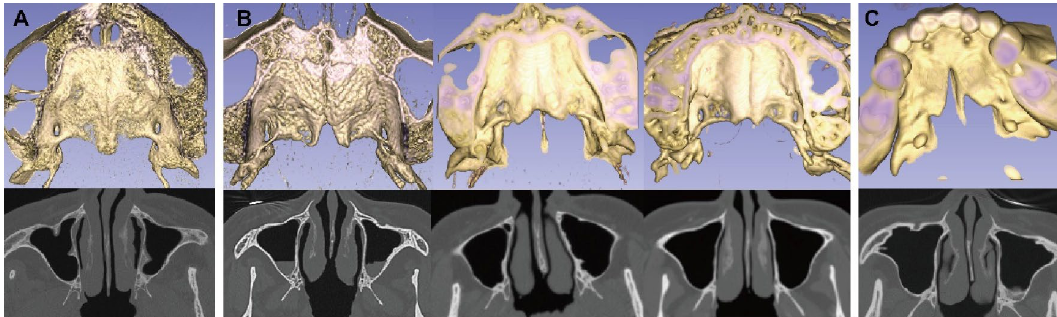
Figure 2. Images of the hard palate bony notch (top) and vomer deformity (bottom). ( A ) Normal hard palate and vomer in patients in the control group. ( B ) Three patients with occult submucosal cleft palate. ( C ) Patient with a history of submucosal cleft palate diagnosis.